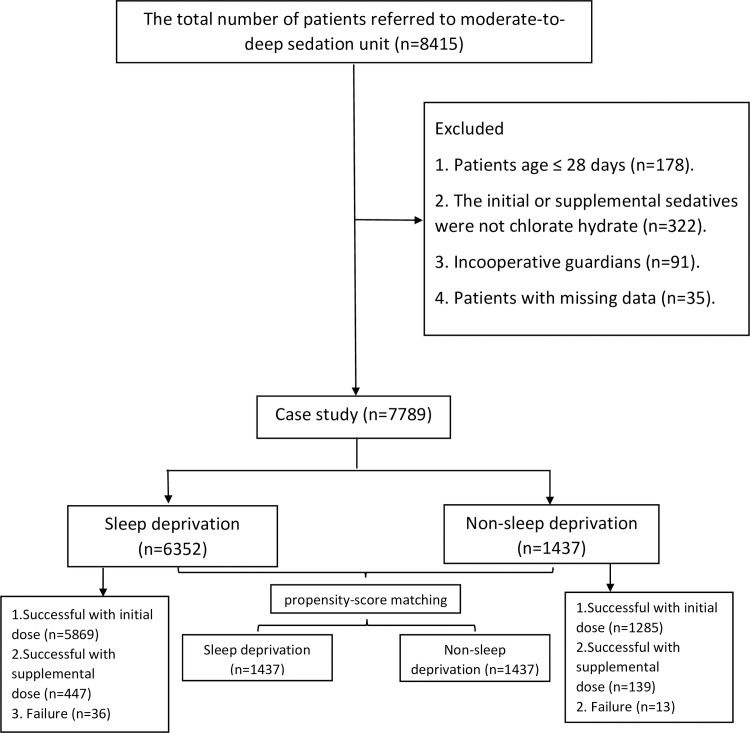
CONSORT flow chart.